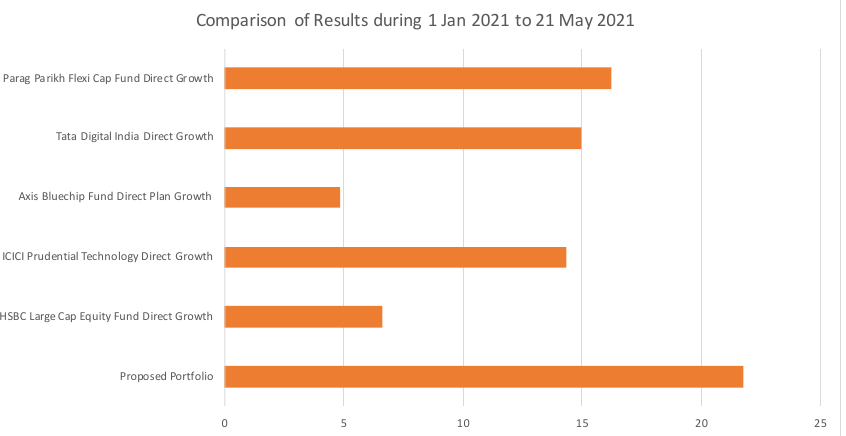
Figure 2. Comparison of the performance of the proposed portfolio with other mutual